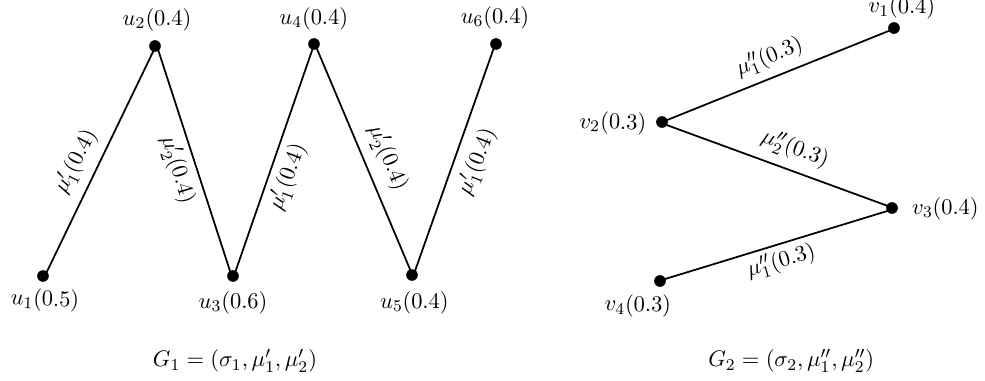
Figure 13. µ (cid:48) Figure 13: µ ′